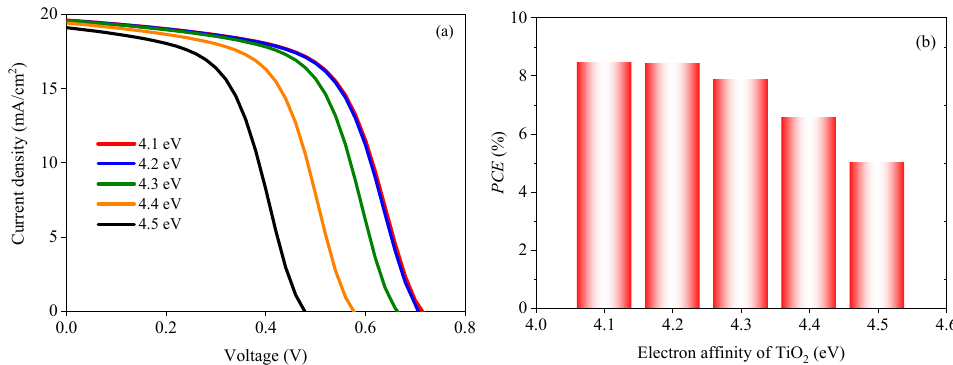
Figure 4. Effect of the electron affinity of TiO 2 on the solar cell: ( a ) J-V characteristic curves under different electron affinities of TiO 2 and ( b ) power conversion efficiency (PCE) under different electron affinities of TiO 2 .